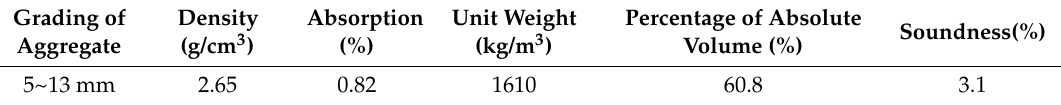
Table 4. Physical properties of coarse